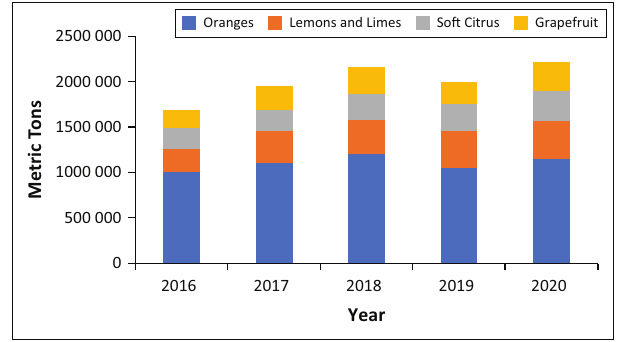
FIGURE 2: South Africa’s citrus production areas.